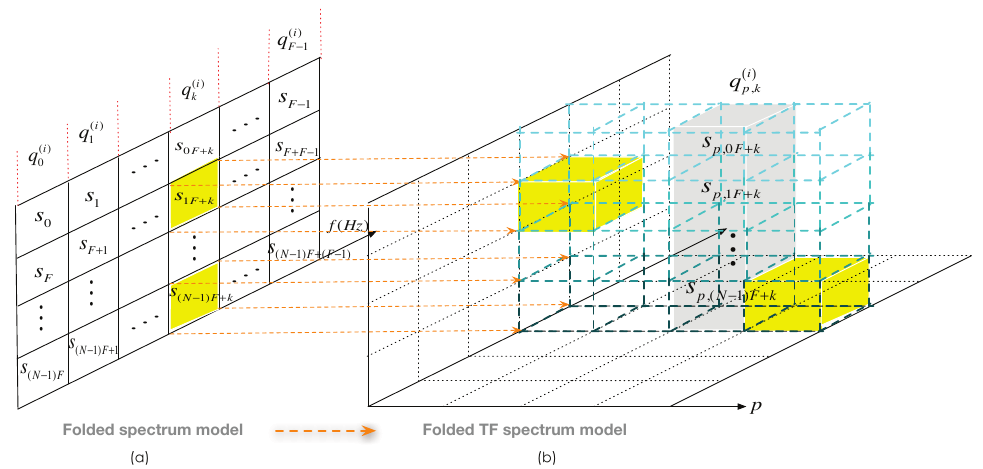
Figure 2. ( a ) The virtual display of the folded spectrum of NoR algorithm. ( b ) The virtual display of the folded TF spectrum of AdNoR